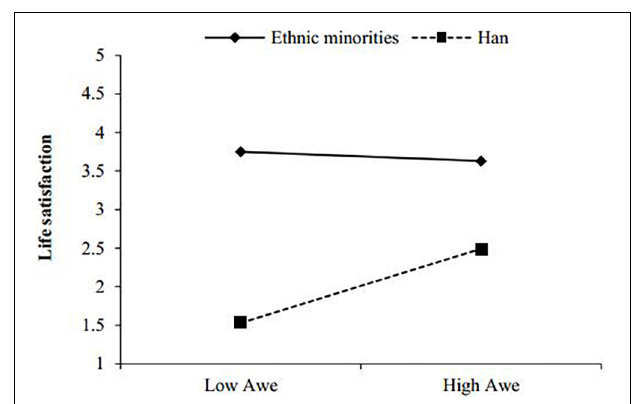
FIGURE 3 | The Moderating Effect of Ethnicity on the Relationship between awe and life